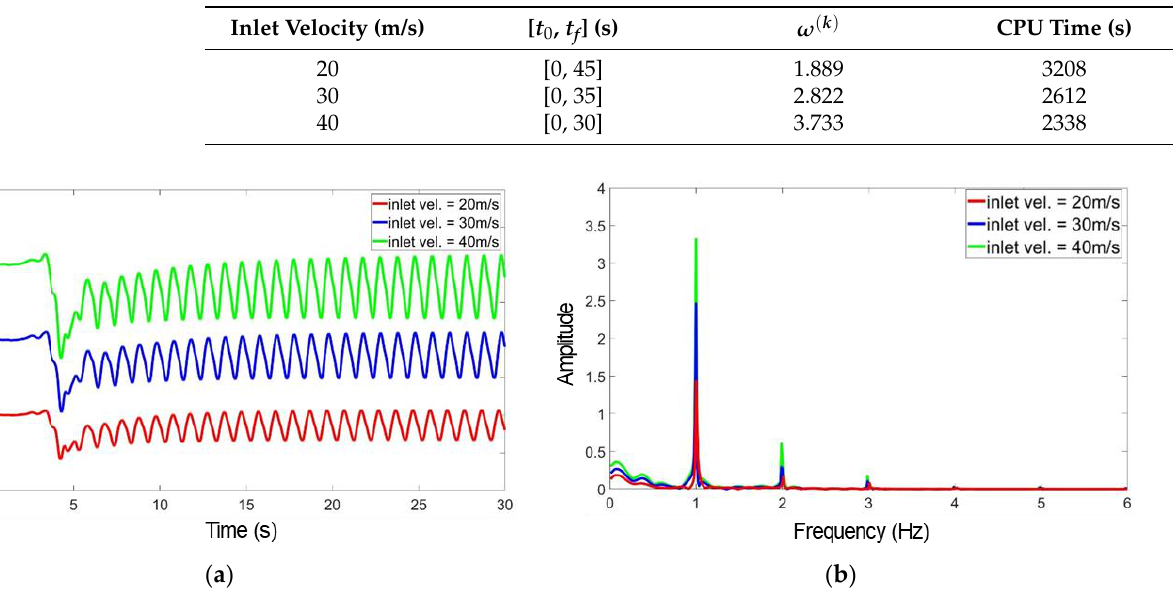
Figure 2. Example 1: Solution responses of sampling cases in x-direction: ( a ) Time domain; ( b ) Frequency domain. Table 1. Example 1: Sampling cases.